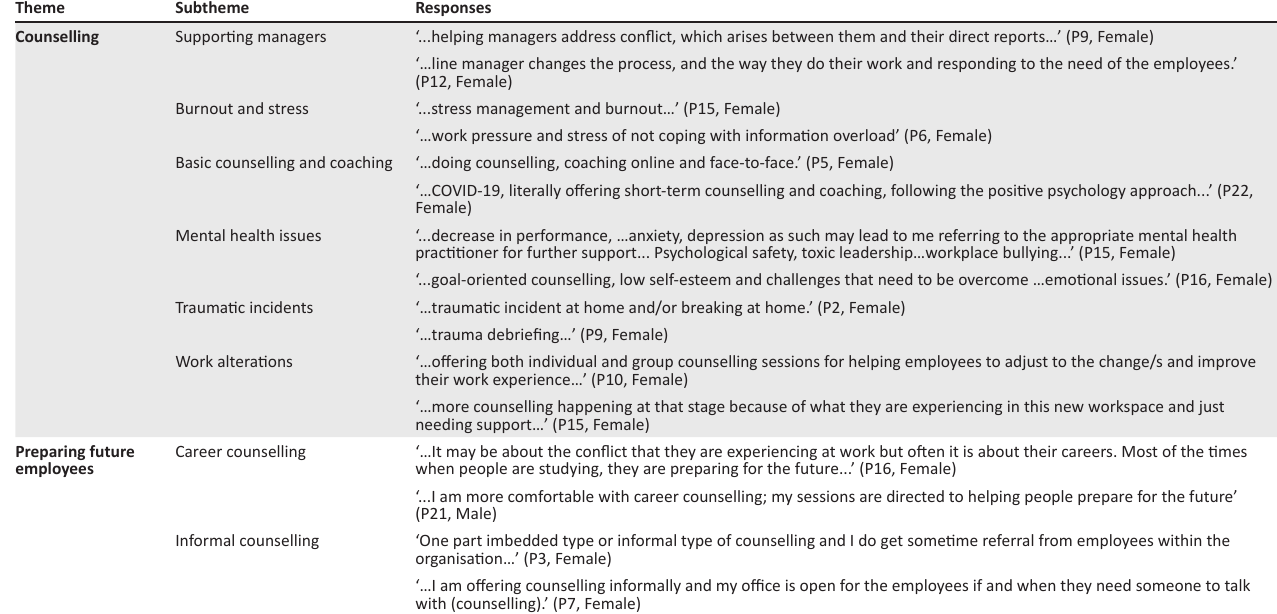
TABLE 2: Category 2: The support industrial psychology practitioners provide to employees in the changing world of work. Theme Subtheme Responses